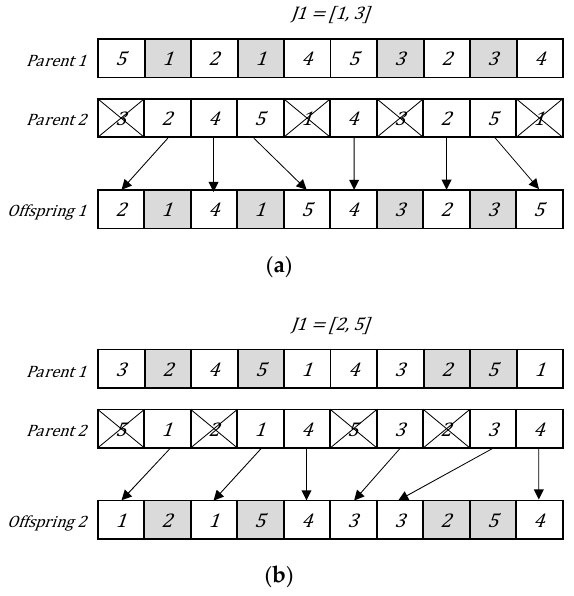
Figure 7. Examples of the POX operation: ( a ) offspring 1 and ( b ) offspring 2.